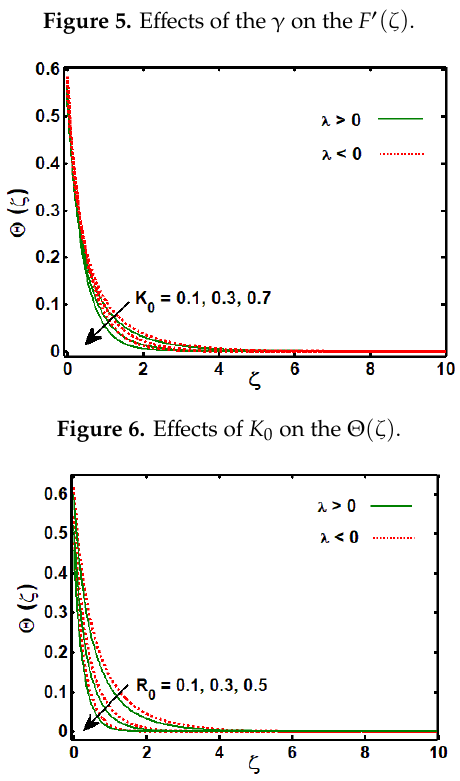
Figure 7. E ff ects of R 0 on the Θ ( ζ ) Figure 7. Effects of 𝐑 𝟎 on the 𝜣(𝜻) . Figure 7. Effects of 𝐑 𝟎 on the 𝜣(𝜻) . Figure 7. Effects of 𝐑 𝟎 on the 𝜣(𝜻) . Figure 7. Effects of 𝐑 𝟎 on the 𝜣(𝜻) .